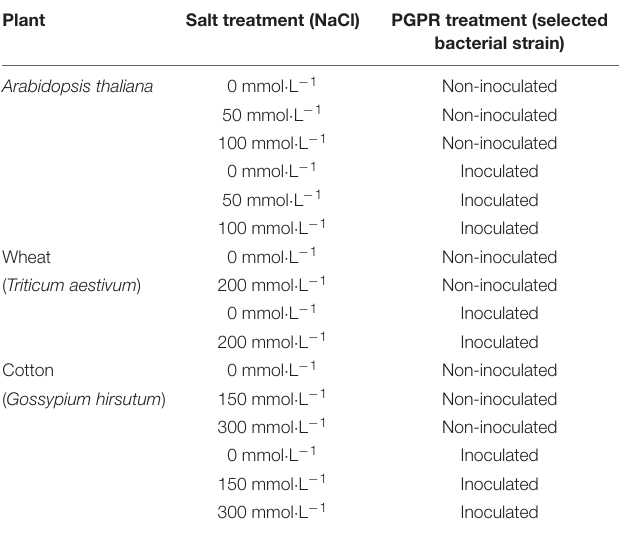
bacterial strain)